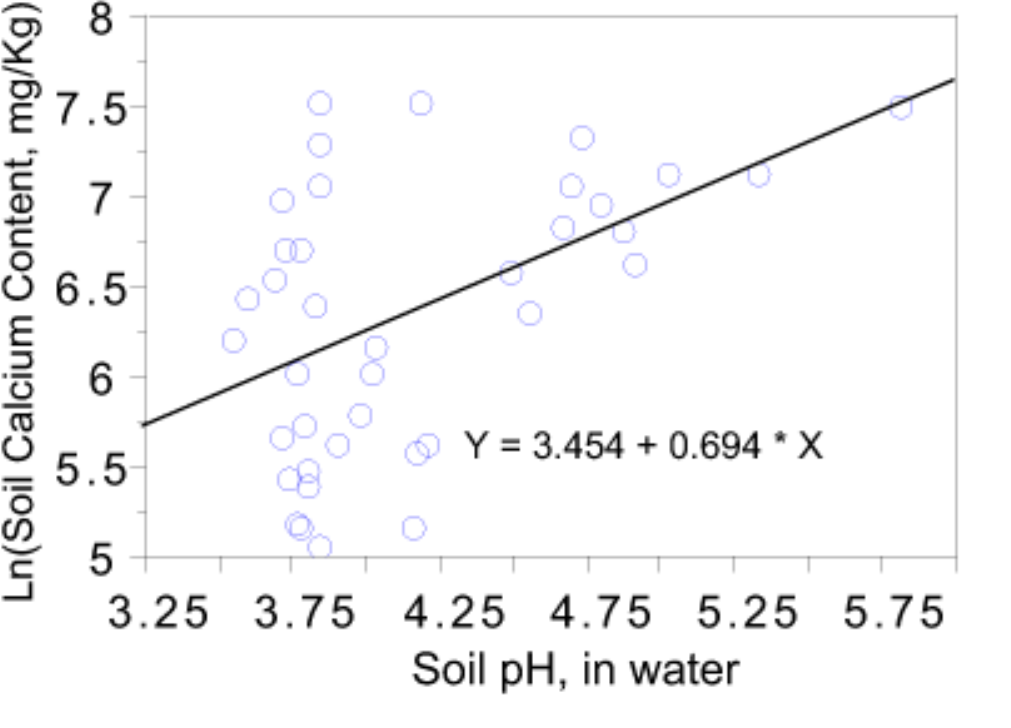
Fig. 3. The relationship between log-transformed soil calcium content in mg/kg and soil pH, measured in water, from each site. Least squares regression yielded a highly significant model: F 0.0015, R 2 = 0.247. Line shown represents the predicted best-fit values from the